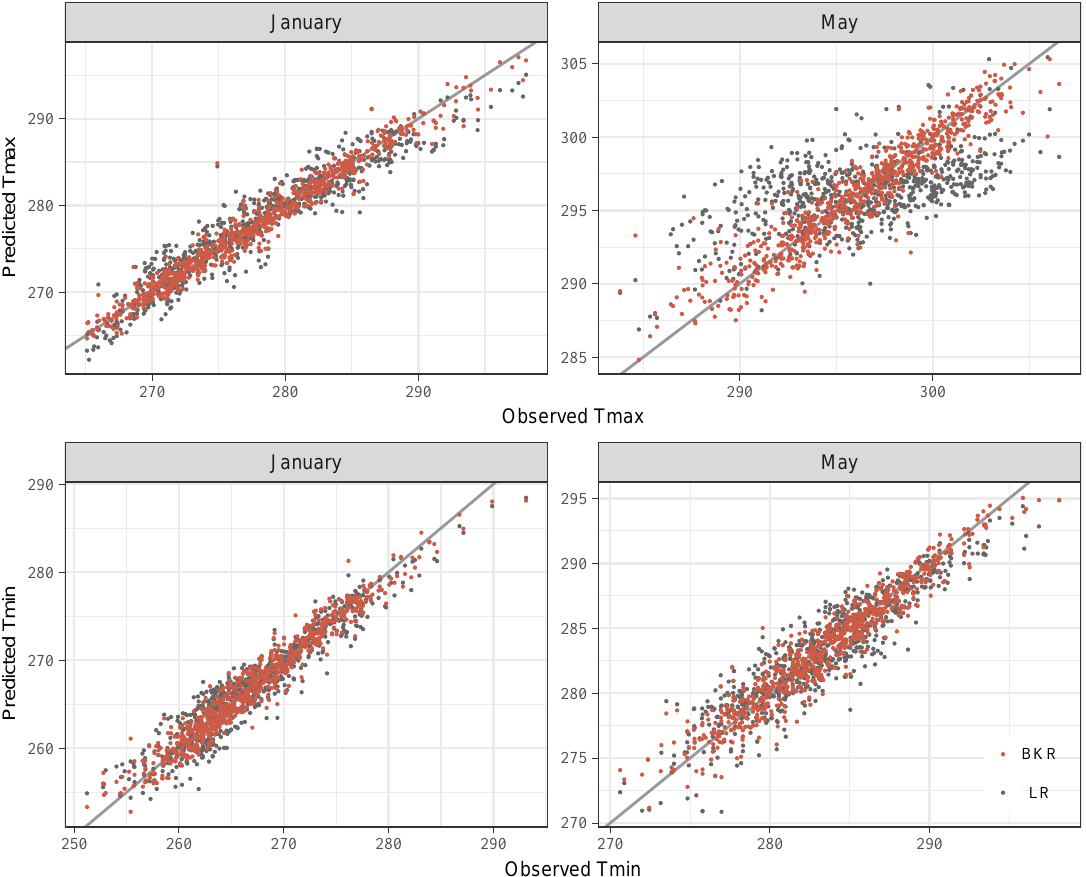
Figure 5. The whole region scenario: observed Ta against predicted Ta from LR and Bayesian Kriging regression (BKR): ( top row ) models in the daytime case (Tmax). ( bottom row ) Models in the nighttime case